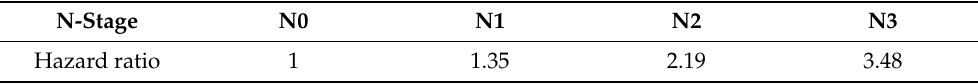
Table A2. Hazard ratios used to define survival rates in the simulation.